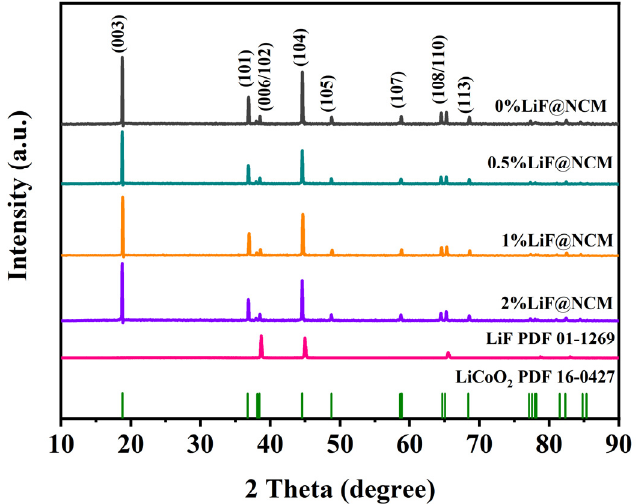
Figure 2. XRD patterns of 0%LiF@NCM, 0.5%LiF@NCM, 1%LiF@NCM, 2%LiF@NCM and LiF.